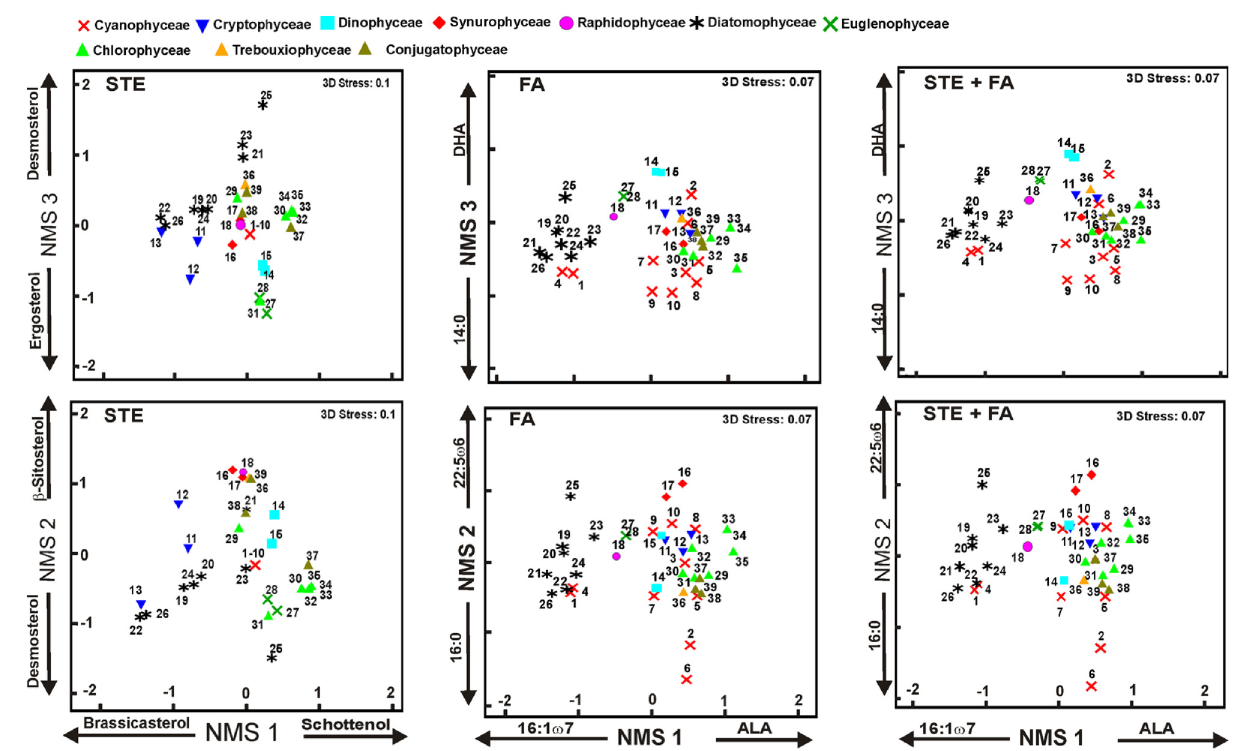
FIGURE 3 | Results of non-metric multidimensional scaling (NMS). The final stress was 0.1 for sterols and 0.07 for other analysis, indicating a reasonable ordination in three dimensions. The plot shows the similarity of ordination based on the sterol (STE), fatty acids (FA), and combined profiles (STE + FA). The strongest correlation of individual sterol or fatty acid is presented for all axes. Phytoplankton strains are presented in Table 3 . Detailed list of correlations is presented in Table 6 .